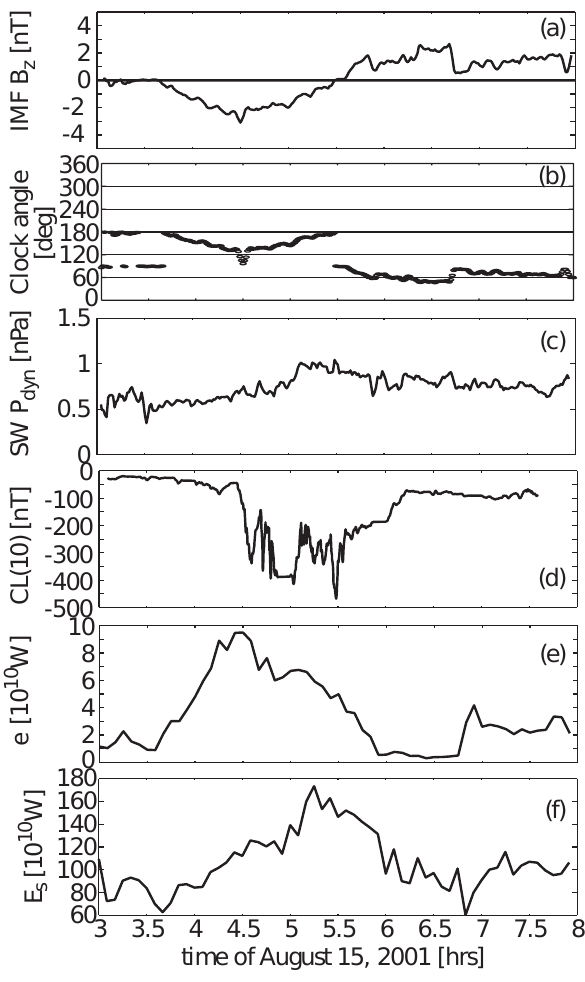
Fig. 2. Solar wind conditions during the 15 August 2001